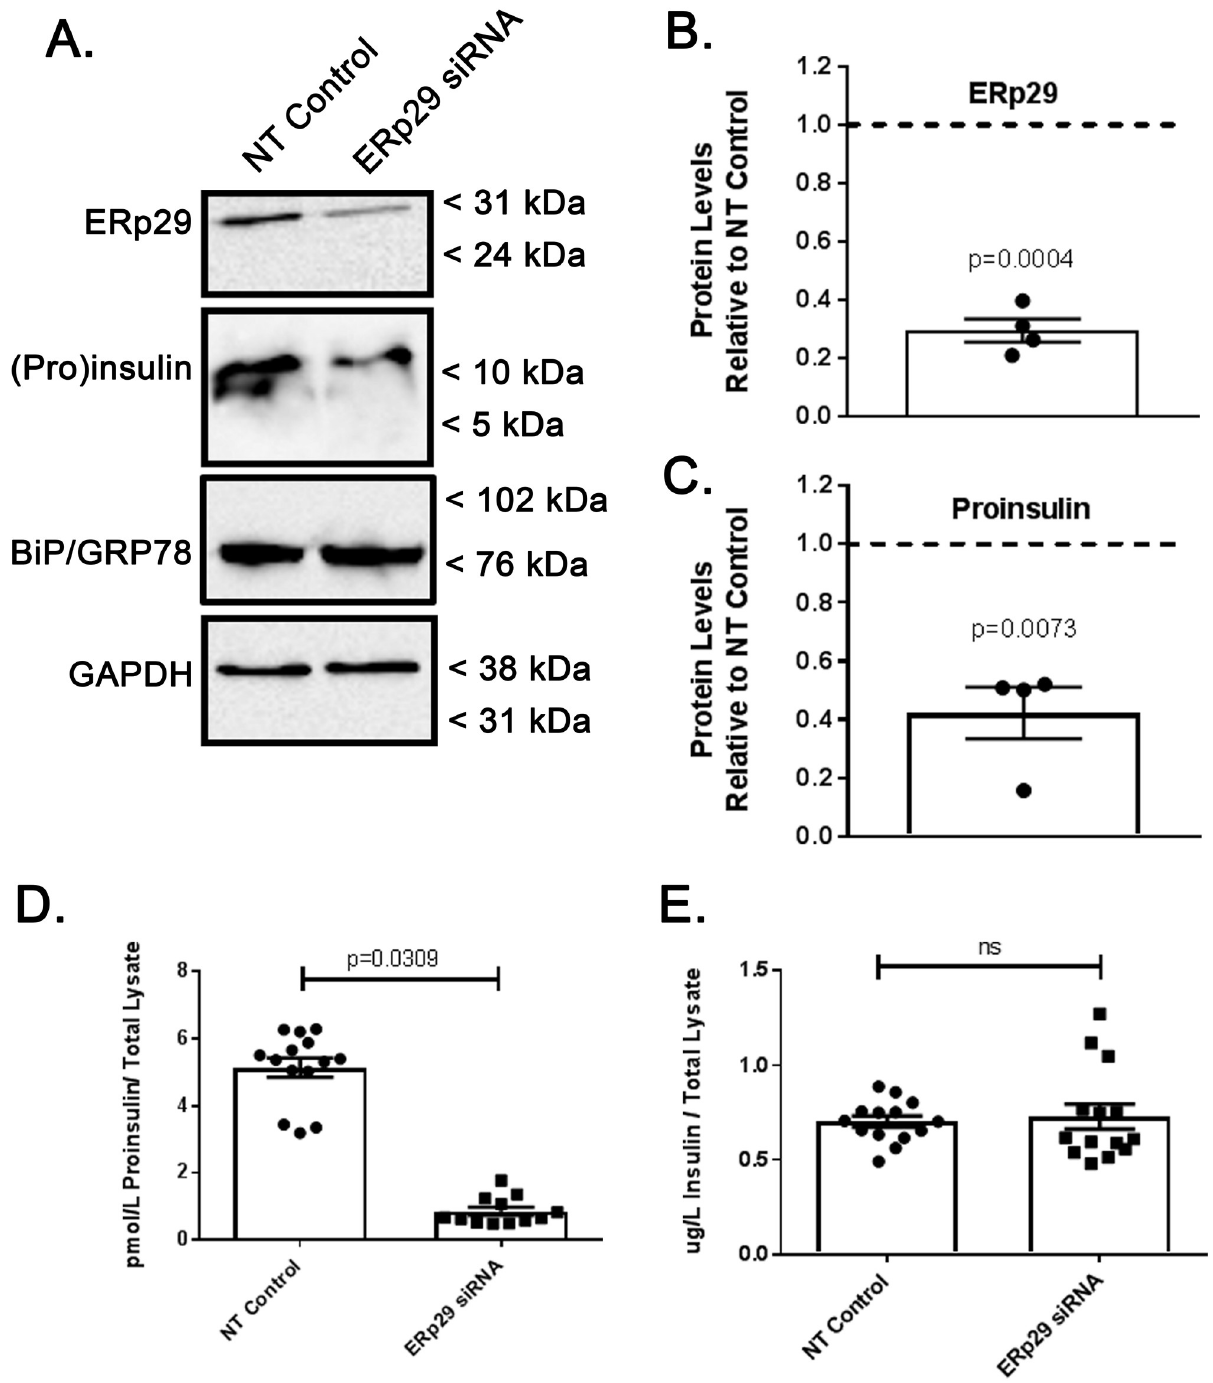
Fig 4. Depletion of ERp29 decreases cellular Proinsulin. Min-6 cells were transfected with ERp29-targeting siRNA or with a non-targeting control siRNA. (A) The resulting depletion of ERp29 and its effect on Proinsulin abundance were then assayed by immunoblot. GAPDH was used as a loading control, and BiP was used to monitor ER stress. These data are representative of n = 4 independent experiments. (B) Densitometric quantification of the relative abundance of ERp29 in transiently transfected Min-6 cells indicate a decrease in ERp29 levels of ~70% when transfected with ERp29-targeting siRNA vs. controls (n = 4, p = 0.004). (C) Densitometric quantification of the relative abundance of Proinsulin in transiently transfected Min-6 cells indicate a corresponding decrease in whole cell lysate levels of ~60% when transfected with ERp29-targeting siRNA vs. controls (n = 4, p = 0.0073). (D, E) Transiently transfected Min-6 cells were lysed and analyzed by ELISA. Proinsulin levels decreased when transfected with ERp29-targeting siRNA as compared to controls (D, p = 0.0309), but Insulin content did not significantly change (E, p = ns).